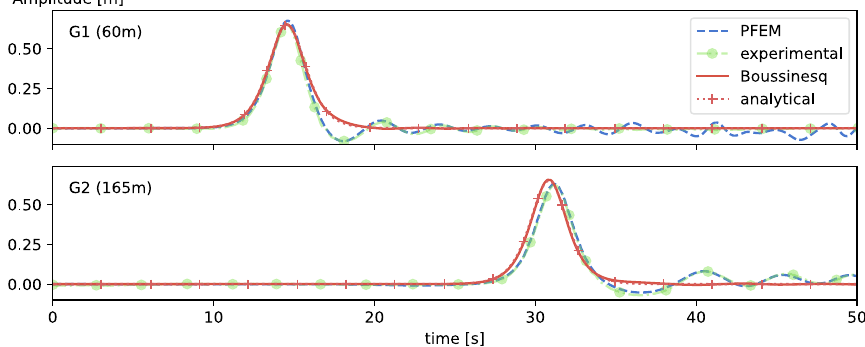
Fig. 5 Solitary wave example. Time evolution of the free surface at two